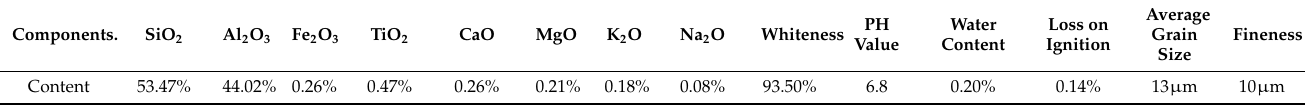
Table 1. Chemical and Physical Composition of metakaolin.